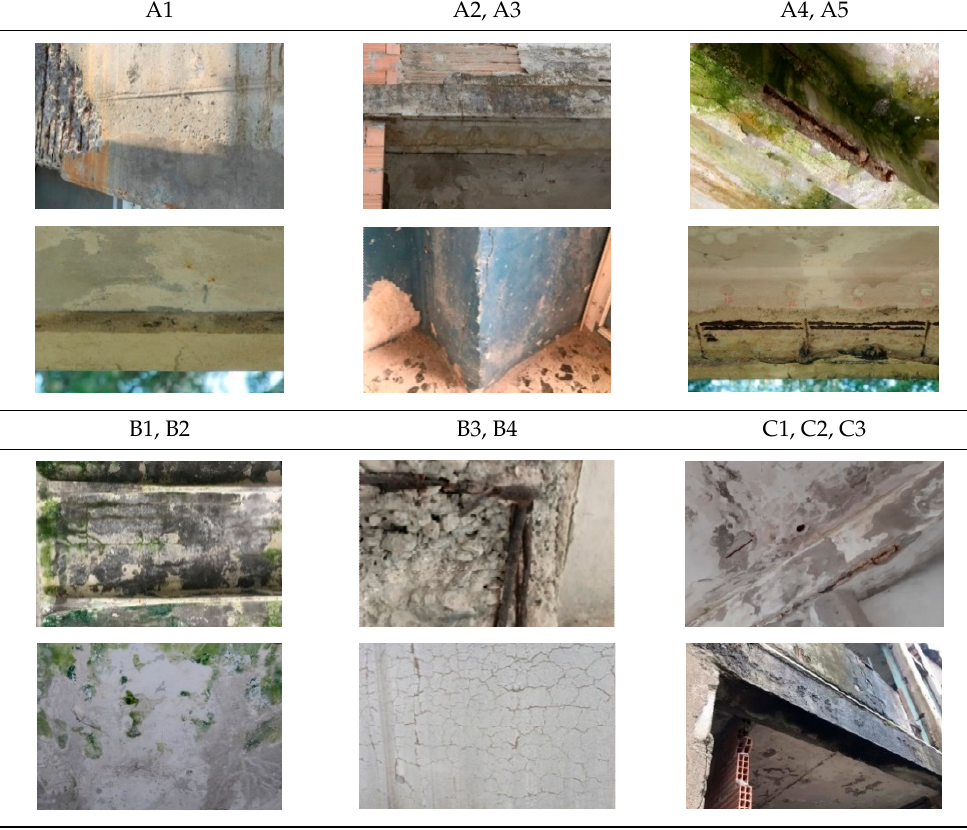
Table 3. Examples of possible visible deterioration conditions. Signs of damage observed during the inspection in buildings from case studies [12].